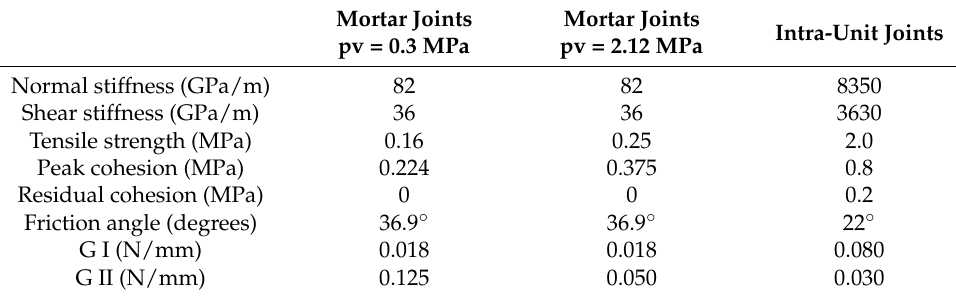
Table 7. Input joint properties for shear panel model.